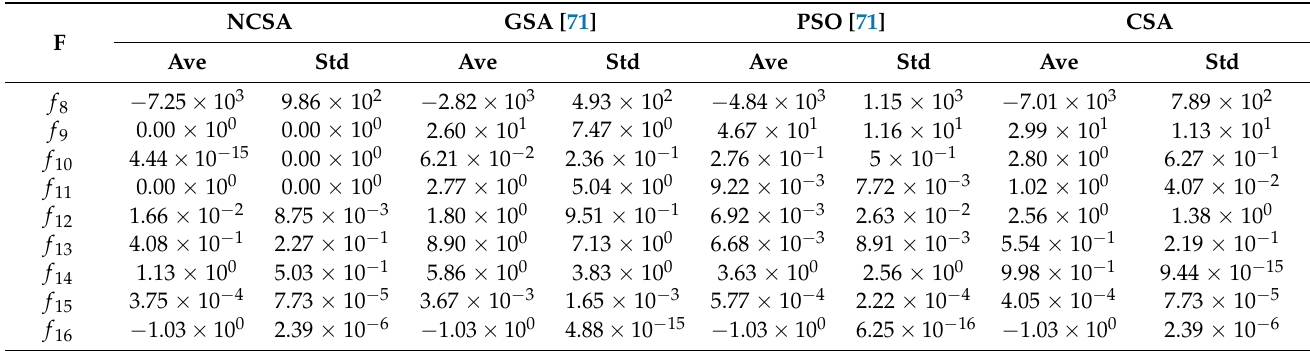
Table 2. Results for multimodal benchmark functions.